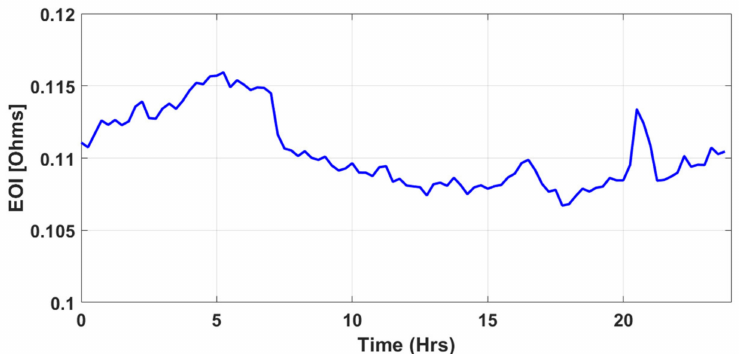
Figure 9. EOI curve over a day to calculate the total technical losses for the loading condition having irregular